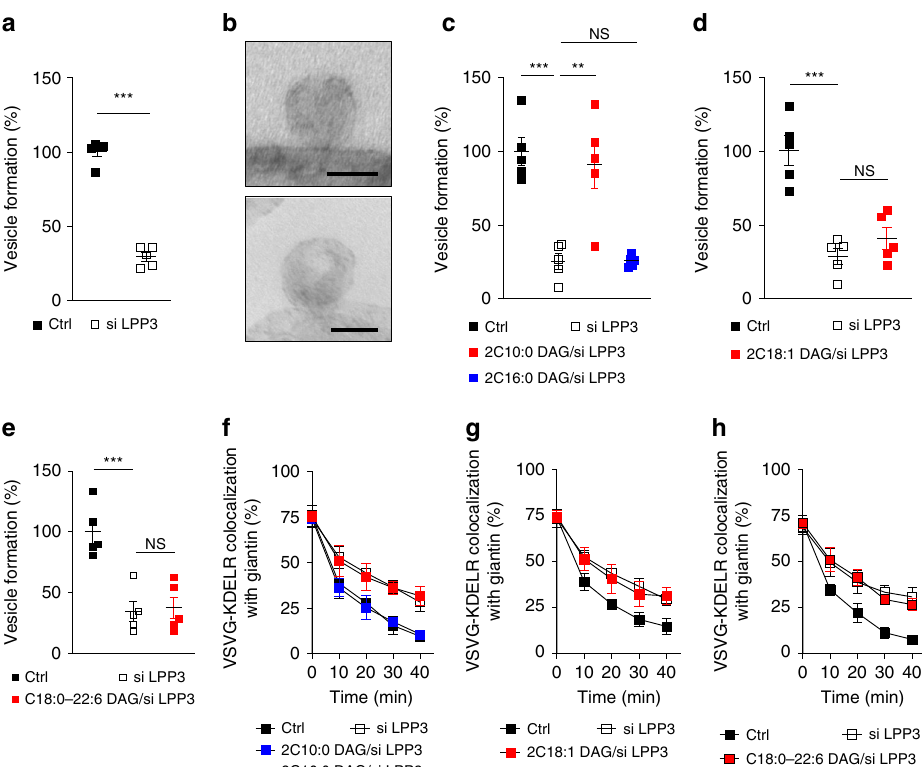
Fig. 3 Diacylglycerol (DAG) in late Coat Protein I (COPI) vesicle fi ssion. Quantitative data are shown as mean ± s.e.m. Signi fi cance was tested using the two-tailed Student ’ s t test, ** P < 0.01, *** P < 0.0001, NS P > 0.05. a Golgi membrane with reduced lipid phosphate phosphatase type 3 (LPP3) level was used for the COPI vesicle reconstitution system; n = 5 independent experiments. b Golgi membrane was isolated from HeLa cells treated with small interfering RNA (siRNA) against LPP3 and then used for incubation in the COPI vesicle reconstitution system. COPI buds on Golgi membrane were then detected by electron microscopy, with representative images shown, bar = 50 nm, n = 3 independent experiments. c Golgi membrane with reduced LPP3 level was used for the COPI vesicle reconstitution system, with rescue of vesicle formation using DAG having varying length of acyl chains as indicated; n = 5 independent experiments. d Golgi membrane with reduced LPP3 level was used for the COPI vesicle reconstitution system, with rescue of vesicle formation using DAG with single unsaturations; n = 5 independent experiments. e Golgi membrane with reduced LPP3 level was used for the COPI vesicle reconstitution system, with rescue of vesicle formation using a polyunsaturated DAG; n = 5 independent experiments. f HeLa cells were treated with siRNA against LPP3 to inhibit COPI transport, with rescue using DAG having varying lengths of acyl chains as indicated. COPI transport in cells was tracked by examining the quantitative colocalization of a COPI-dependent cargo protein (VSVG-KDELR) with Golgi marker (giantin) at different time points as indicated, n = 4 independent experiments. g HeLa cells were treated with siRNA against LPP3 to inhibit COPI transport, with rescue using DAG having single unsaturations. COPI transport in cells was tracked by examining the quantitative colocalization of a COPI-dependent cargo protein (VSVG-KDELR) with Golgi marker (giantin) at different time points as indicated, n = 4 independent experiments. h HeLa cells were treated with siRNA against LPP3